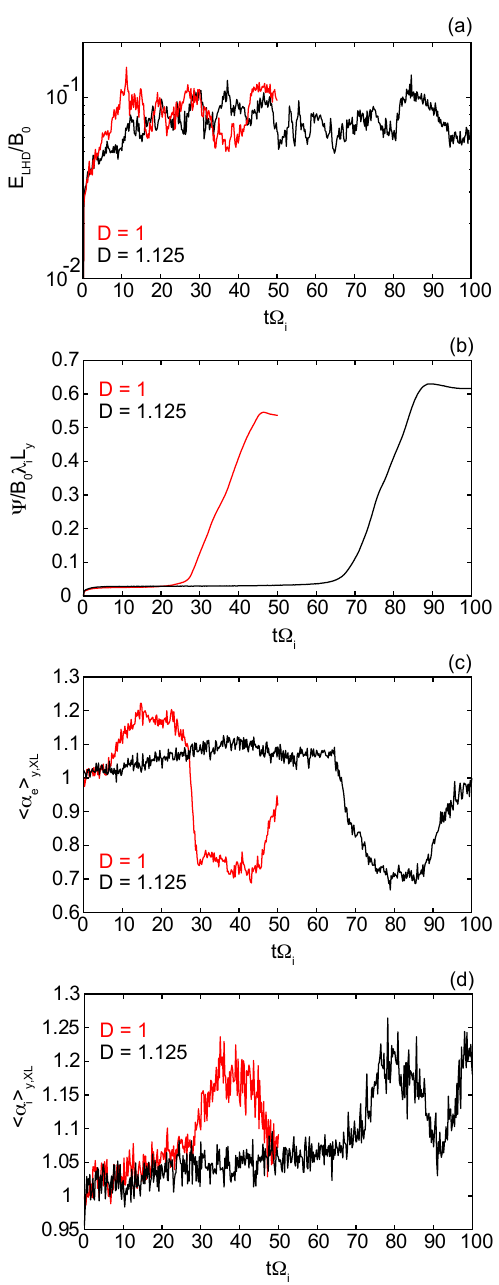
Figure 1 Fig. 1. Comparison between the D =1 and the D=1.125 cases with α io = α eo =1. Red (black) lines in panels (a), (b), (c), and (d) rep- resent the D =1 (1.125) case. (a) The temporal developments of the LHDI activity E LHD . (b) The temporal development of recon- nected magnetic flux 9 . (c) The temporal variation of the electron temperature anisotropy at the X-line <α e > y,XL . (d) The temporal variation of the ion temperature anisotropy at the X-line <α i > y,XL . In both cases, explosive reconnection (starts at t =27 and 60, respec- tively) is involved and grows in a similar manner. The problem, however, is that saturation level of 9 turns out to be rather low al- ready at D